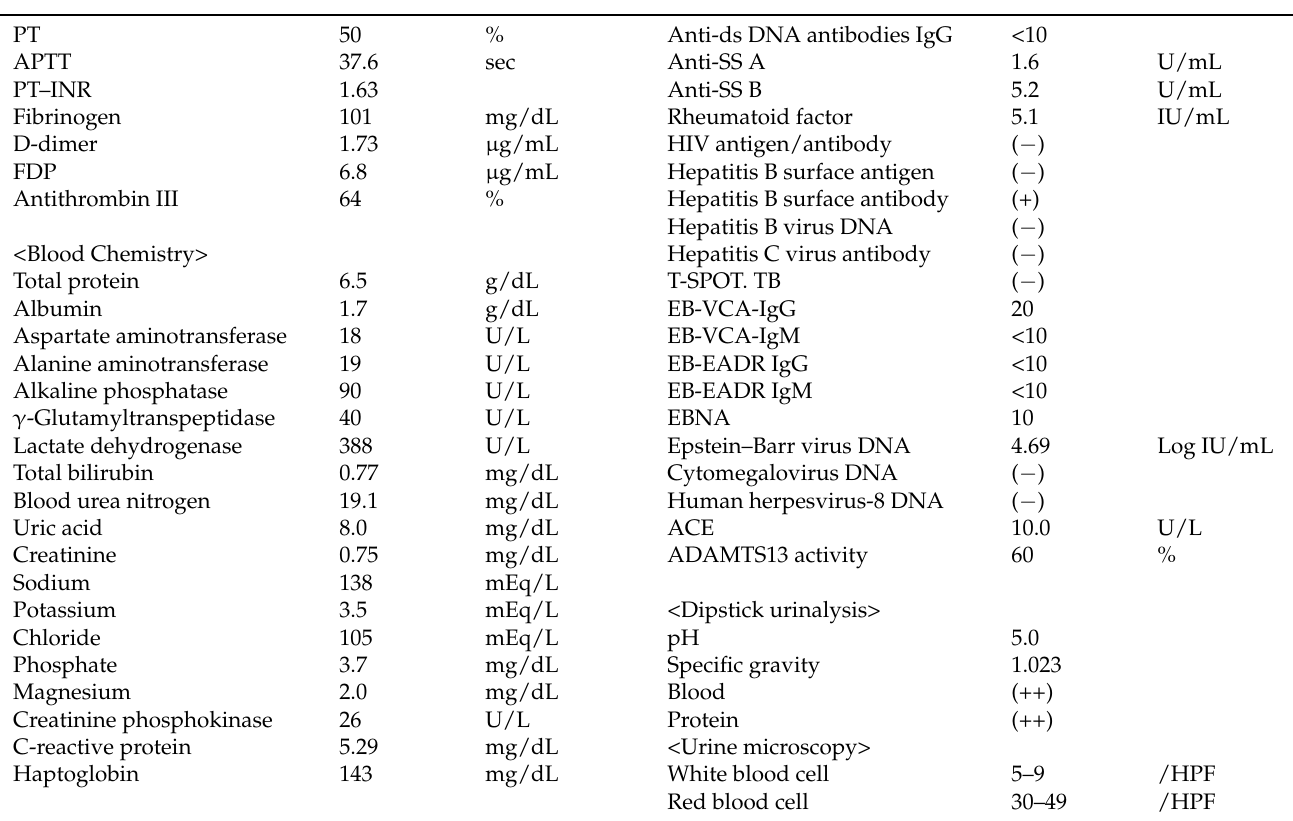
Figure 4. Inguinal lymph node biopsied on day 18 of admission. ( A ) Human herpesvirus-8 latency- associated nuclear antigen-1 (HHV-8 LANA-1) was negative in lymph node specimens. Magnifica- tion ×200; ( B ) hematoxylin and eosin staining demonstrating lymphoid follicles markedly atrophic, with a dense vascular proliferation of high endothelial venules between the follicles. Magnification ×200; ( C ) CD23 staining displaying barely visible lymphoid follicles, with a disorganized network of follicular dendritic cells extending beyond the pre-existing germinal center. Magnification ×200; ( D ) CD38 staining showing infiltration of positive plasma cells and small lymphocytes around blood